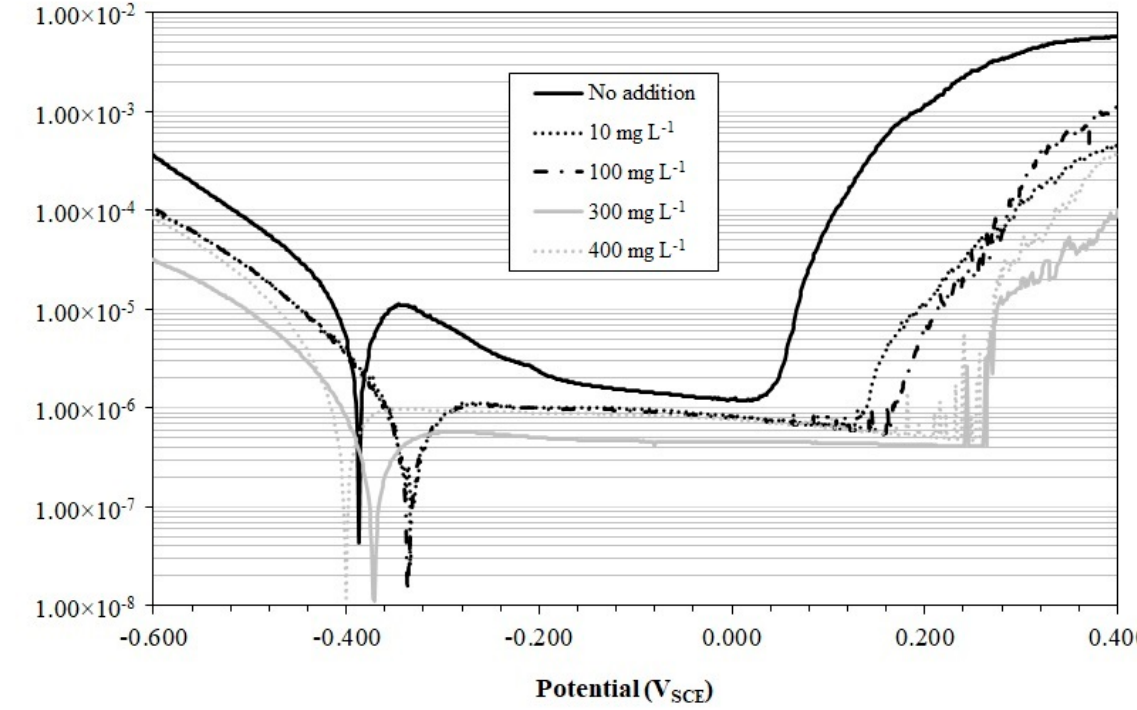
Figure 3. Potentiodynamic polarization curves of 304 stainless steel in hydrochloric acid solution with and without the addition of Terminalia bellirica fruit extract.